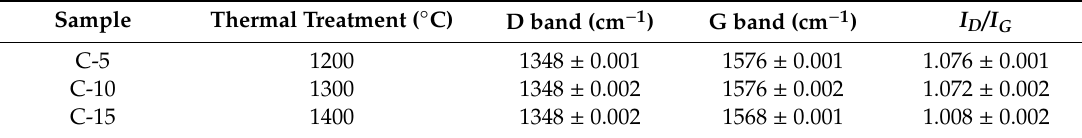
Table 2. The positions of D and G bands ant the ratio of I D / I G intensity corresponding to the heat-treated samples.